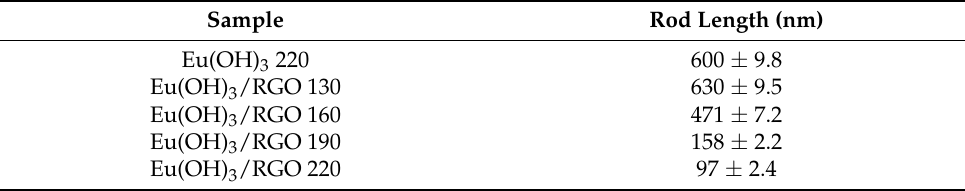
Table 1. Average rod lengths (±standard deviation, SD) of Eu(OH) 3 , Eu(OH) 3 /RGO 220, Eu(OH) 3 /RGO 190, Eu(OH) 3 /RGO 160, and Eu(OH) 3 /RGO 130.